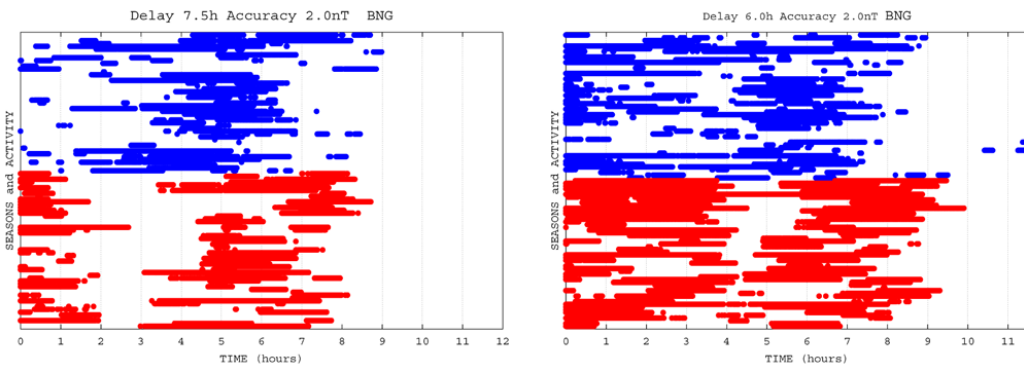
Fig. 9. Time table for BNG data. Same legend as for Fig. 7.